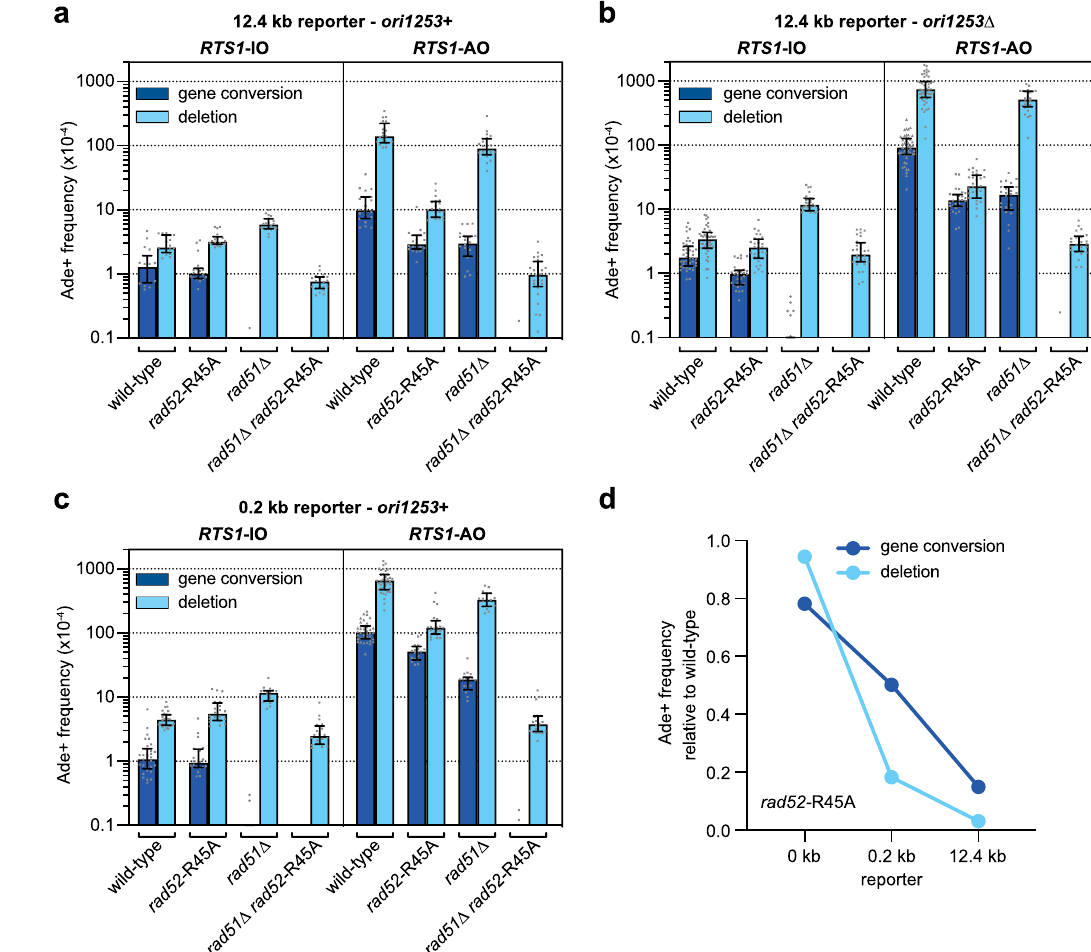
data points shown as grey dots. The data are also reported in Supplementary Table1, which includesthe strain numbers, the numberof coloniestested foreach strain ( n ) and p values. Further details of the statistical analysis are reported in Supplementary Data 1.Source data are provided asa Source Data fi le. d Frequency of RTS1 -AO-induced Ade + recombinants in a rad52 -R45A mutant relative to wild- type. Values are derived from the data in ( a – c